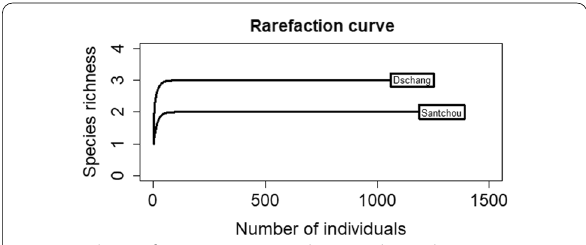
Fig. 4 Culex rarefaction curve in Dschang and